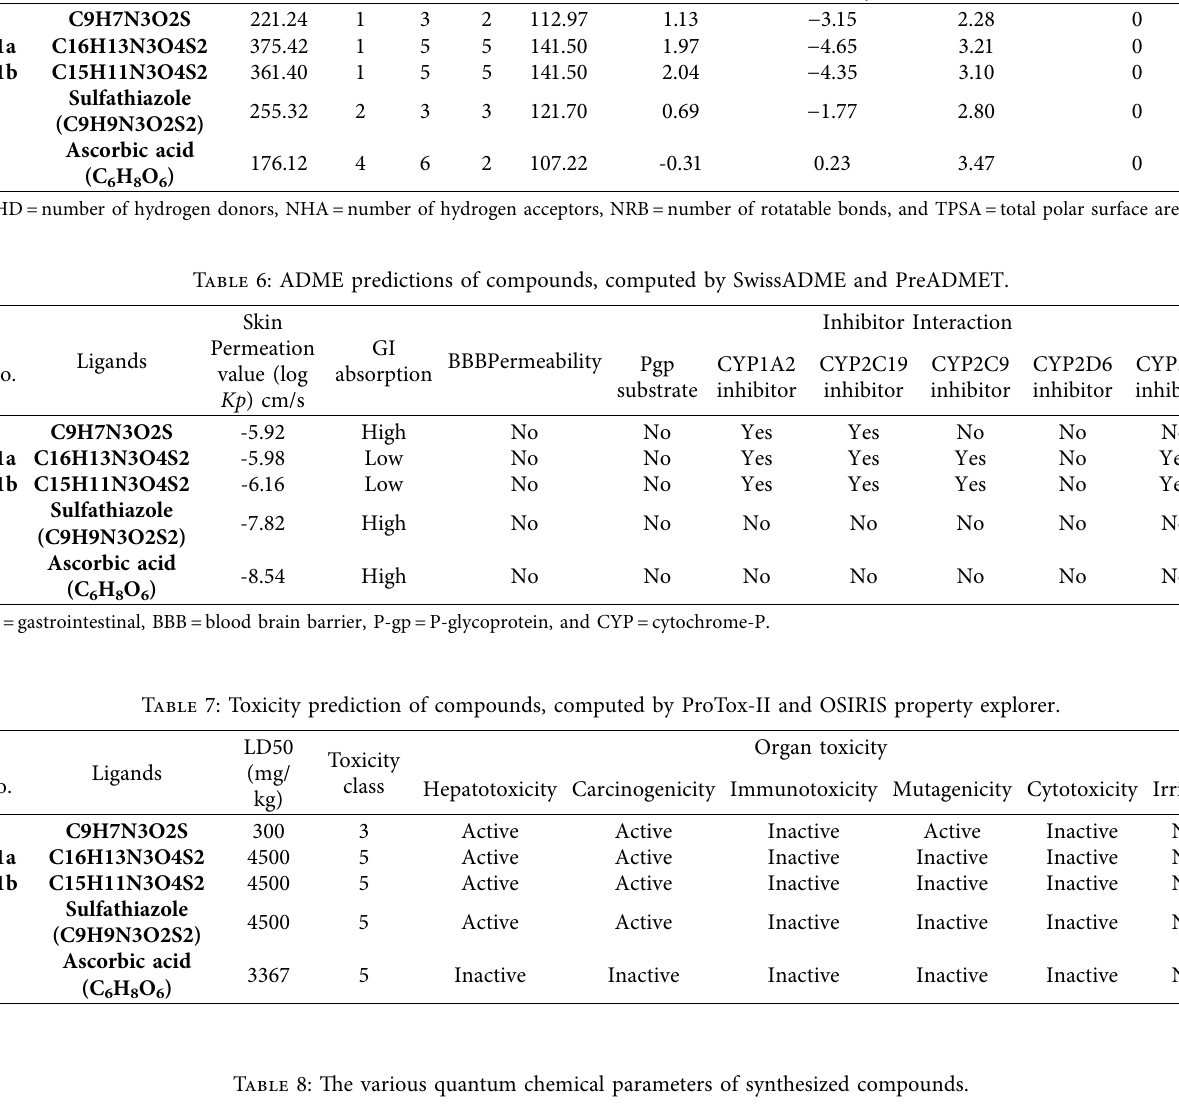
Table 8: The various quantum chemical parameters of synthesized compounds. S.